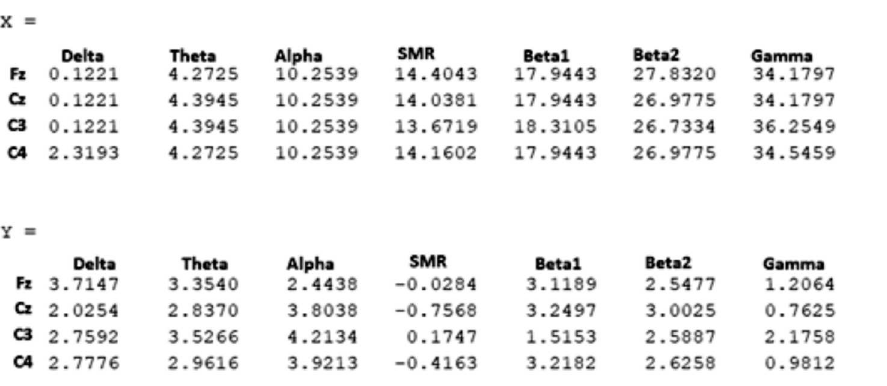
Figure 5. Sample matrix